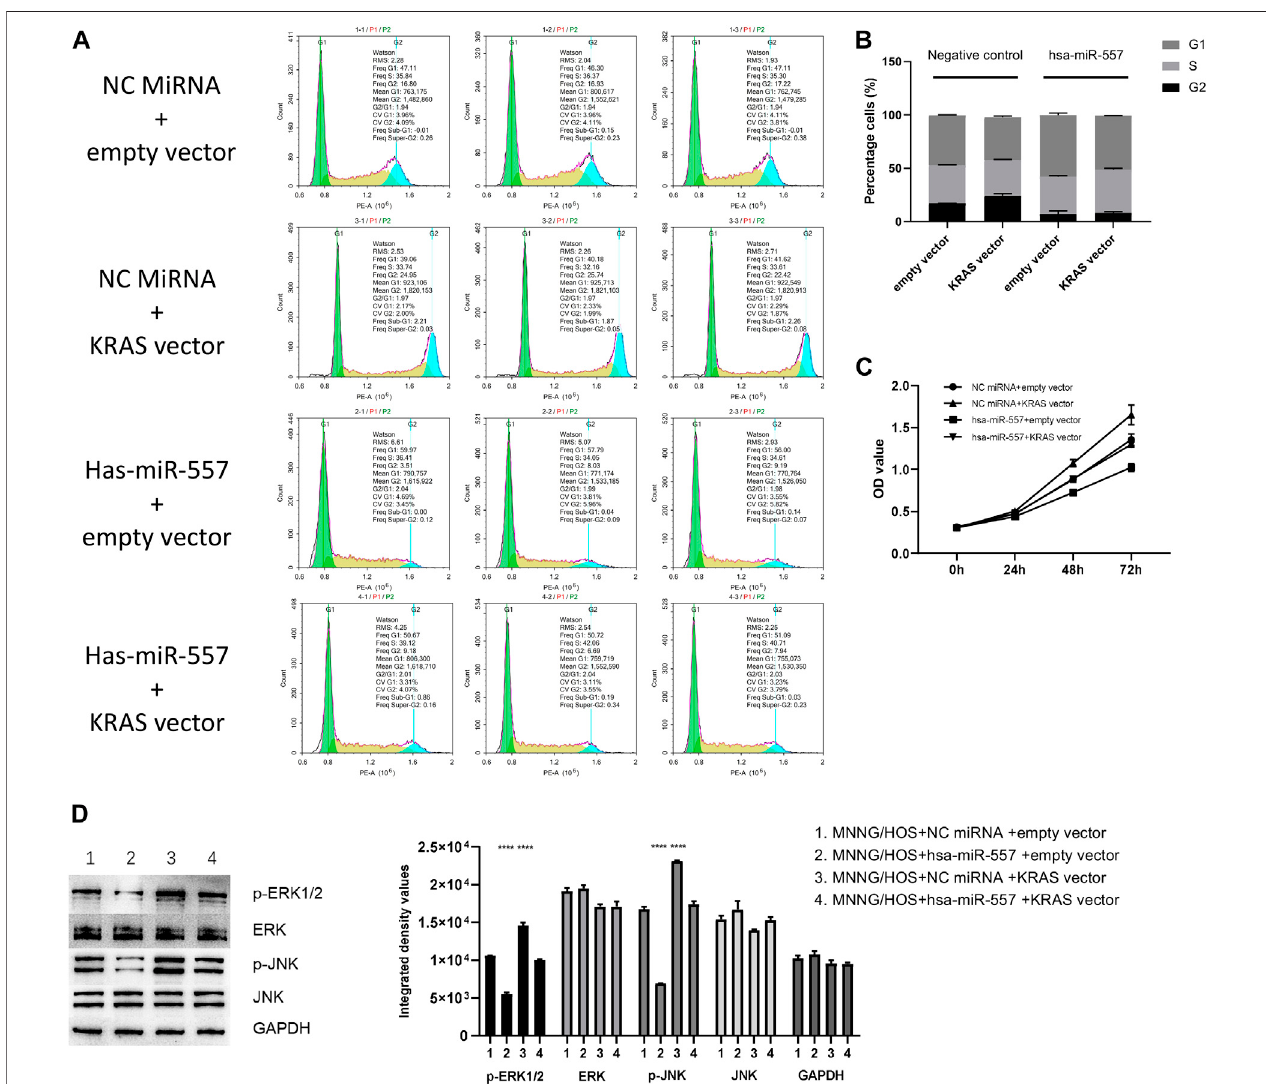
FIGURE 5 | Hsa-miR-557 inhibits the growth of osteosarcoma through targeting KRAS and its downstream molecules. (A,B) Cell cycle analysis showed that hsa- miR-557couldinhibittheproliferationofosteosarcomacellsthroughKRAS(NCmiRNA+emptyvectorvsNCmiRNA+KRASvector: p (cid:1) 0.0021,t (cid:1) 7.114,NCmiRNA+ empty vector vs hsa-miR-557 + empty vector: p (cid:1) 0.0007, t (cid:1) 9.457, hsa-miR-557 + KRAS vector vs hsa-miR-557 + empty vector: p (cid:1) 0.0038, t (cid:1) 6.039). (C) CCK-8 showed that KRAS could alleviate the inhibition effect of hsa-miR-557 on osteosarcoma (NC miRNA + empty vector vs hsa-miR-557 + empty vector: p (48 h) (cid:1) 0.0003,q(48 h) (cid:1) 6.522, p (72 h) < 0.0001,q(72 h) (cid:1) 13.84);NCmiRNA+emptyvectorvsNCmiRNA+KRAS: p (48 h) < 0.0001,q(48 h) (cid:1) 8.080, p (72 h) < 0.0001,q (72 h) (cid:1) 12.380;NCmiRNA+KRASvectorvshsa-miR-557+KRASvector, p (48 h) < 0.0001,q(48 h) (cid:1) 7.815, p (72 h) < 0.0001,q(72 h) (cid:1) 14.72). (D) Phosphorylation of ERK1/2 and JNK was promoted by KRAS with NC miRNA and inhibited by hsa-miR-557 mimic (**** p < 0.0001).